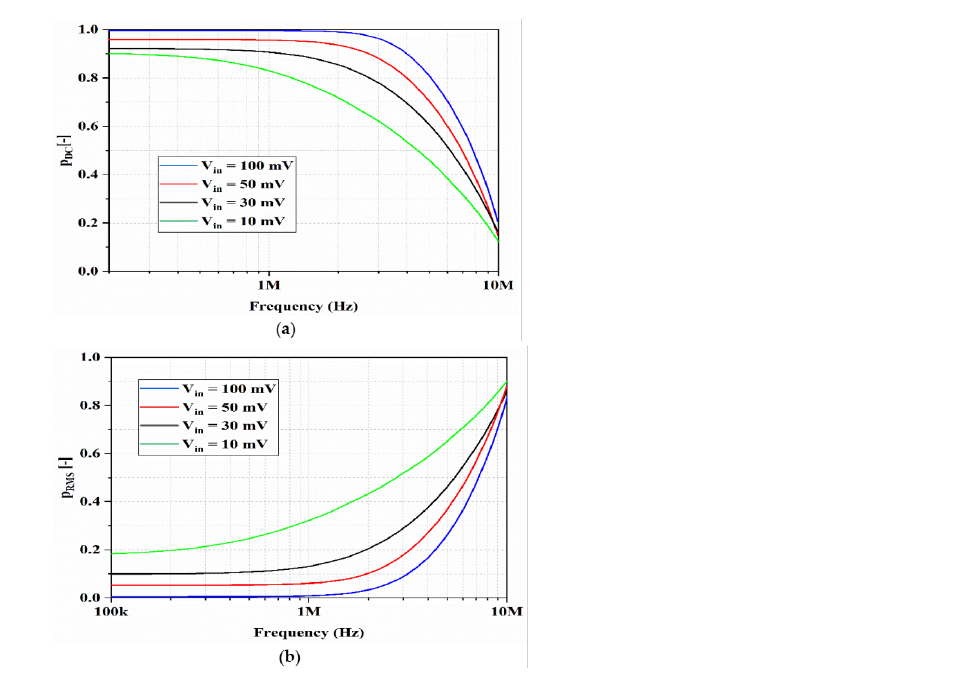
Figure 14. ( a ) Transfer Value P DC for different input signal magnitude ( b ) RMS error P RMS for different input signal magnitude.